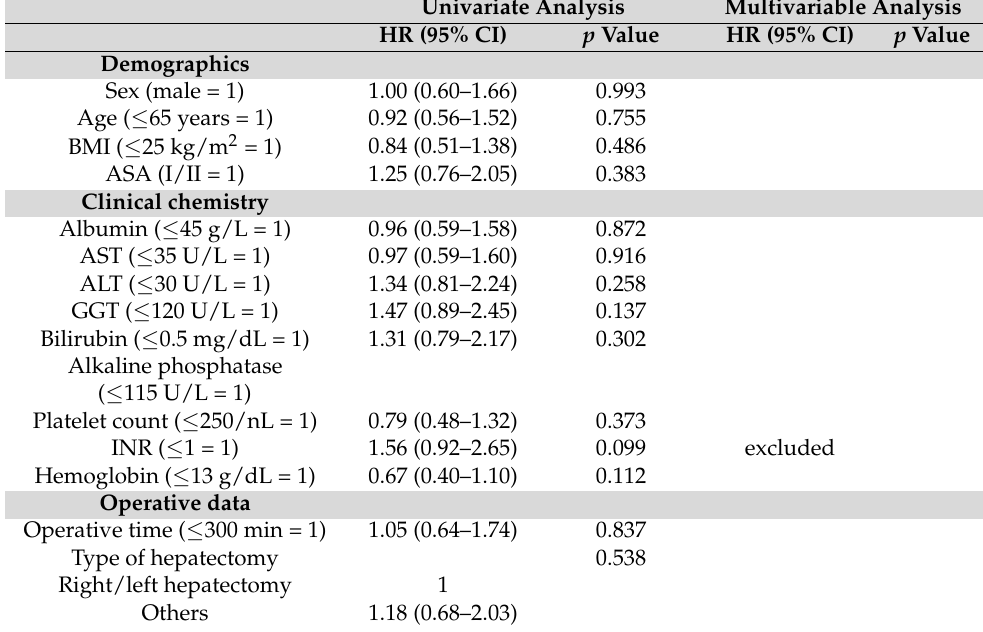
Table 3. Univariate and multivariable analysis of recurrence-free survival in intrahepatic cholangio- carcinoma. Various parameters are associated with recurrence-free survival. ALT, alanine aminotrans- ferase; ASA, American society of anesthesiologists classification; AST, aspartate aminotransferase; BMI, body mass index; GGT, gamma glutamyltransferase; INR, international normalized ratio; LVI, lympho-vascular invasion; MVI, microvascular invasion; NF, nerve fibers; PNI, perineural invasion. Univariate